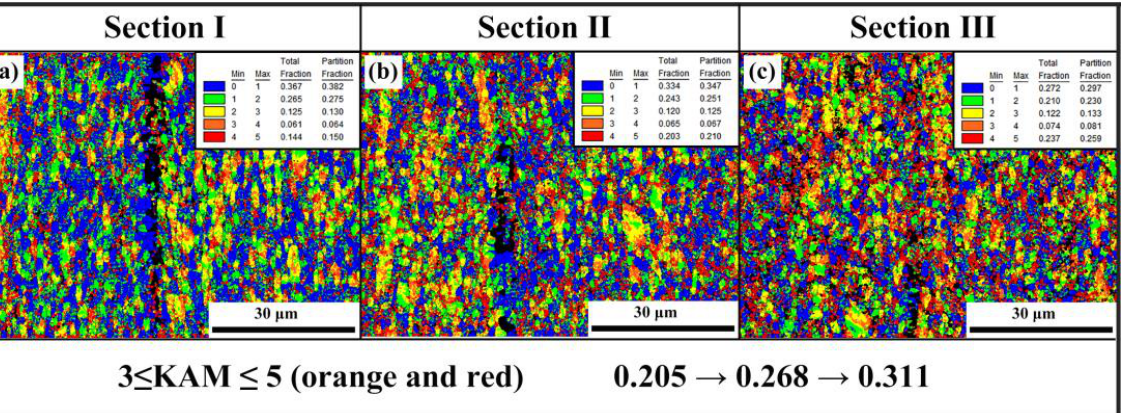
Figure 3. The KAM mappings of tensile specimen with different location: ( a ) I arc area, ( b ) II close to arc area, ( c ) III near fracture area.